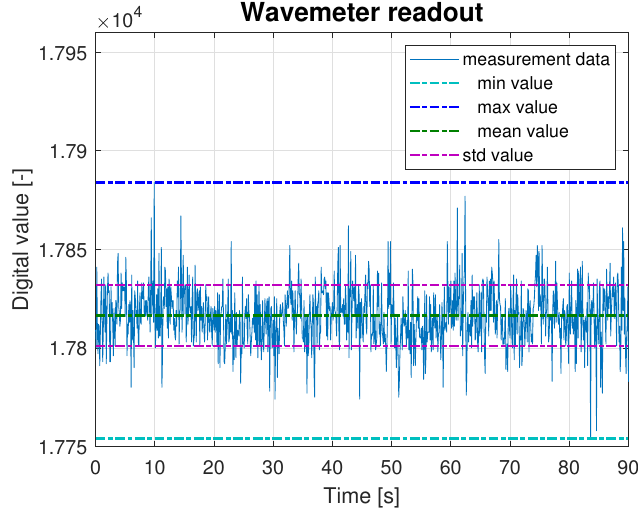
Figure 2. Example of wavemeter readout retrieved from the scaling experiment.